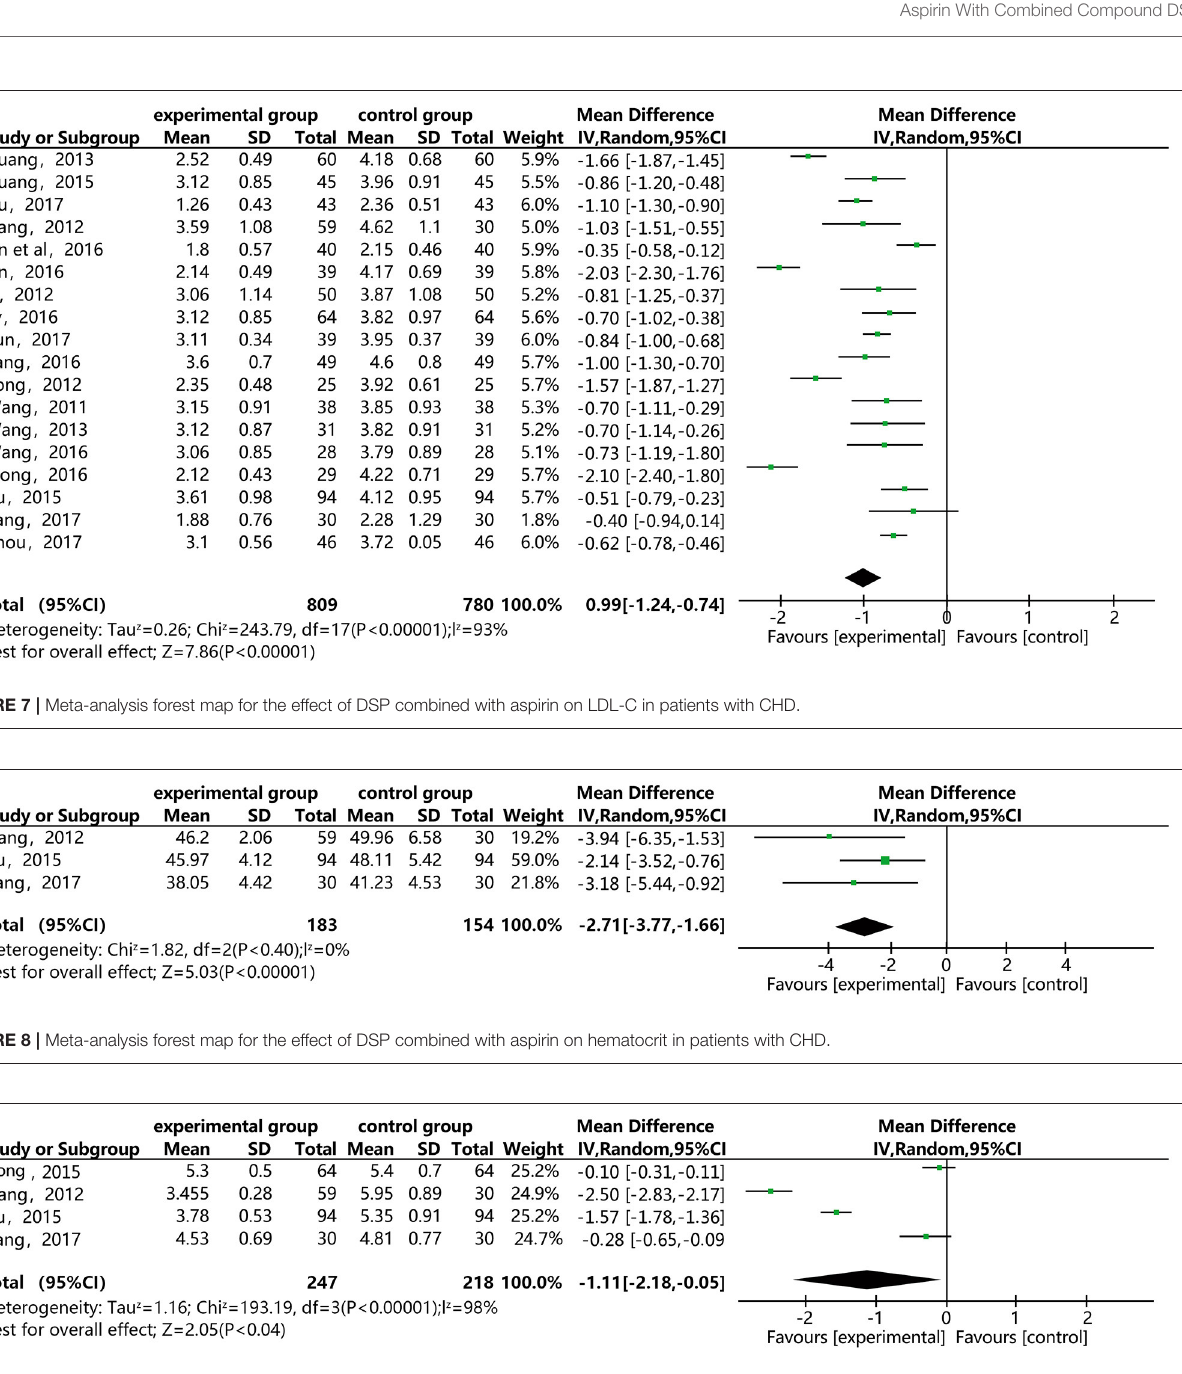
FIGURE 9 | Meta-analysis forest map of the effect of DSP combined with aspirin on high shear blood viscosity in patients with CHD.